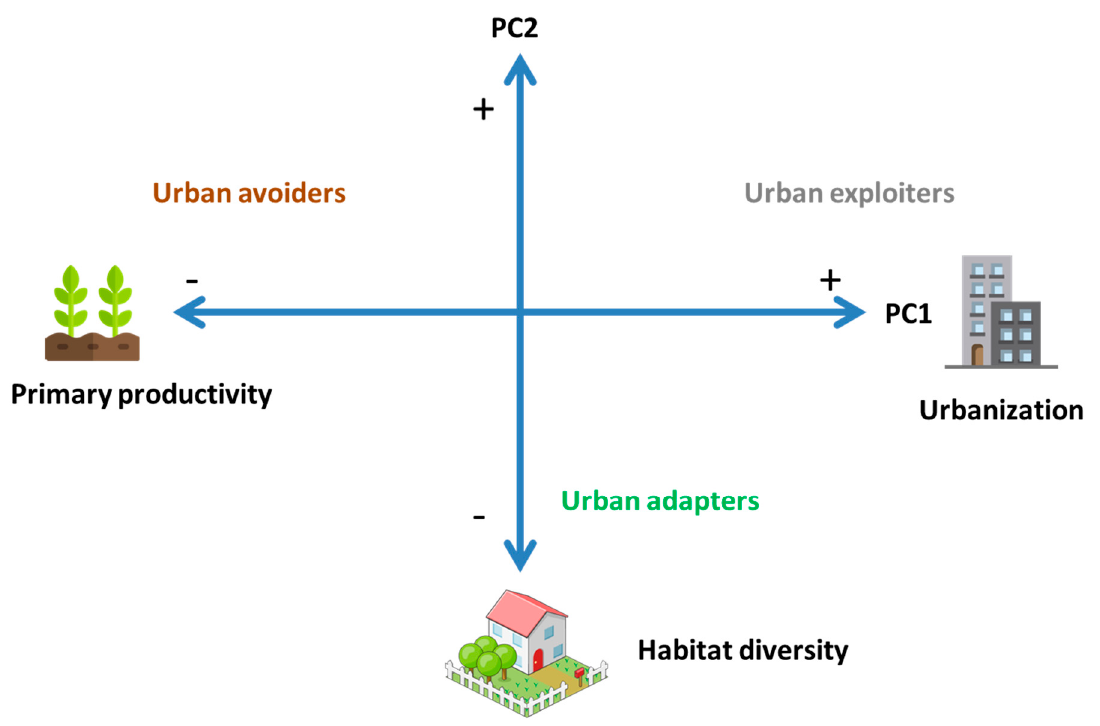
Figure 1. Schematic representation of the ordination of bird species and environmental variables. Urbanization includes the median impervious cover, vehicle and pedestrian traffic, and distance to rural areas for the records of each species. Primary productivity is the median NDVI value for the records of each species. Habitat diversity is the median Shannon index calculated with percent cover of vegetation strata and building cover.